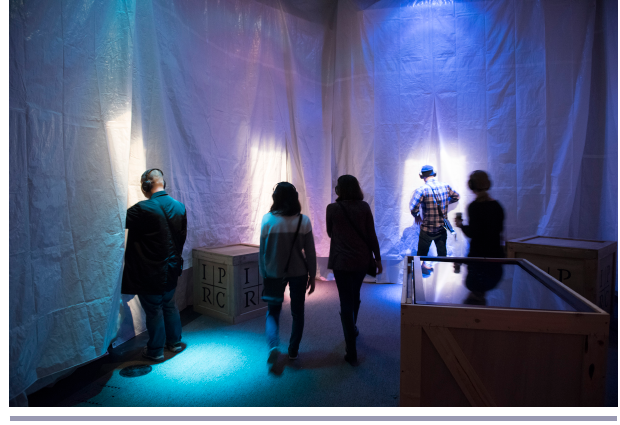
Fig. 3 . Main gallery after the appearance of light cues for the three rooms. (Photo by Emily Cooper.)